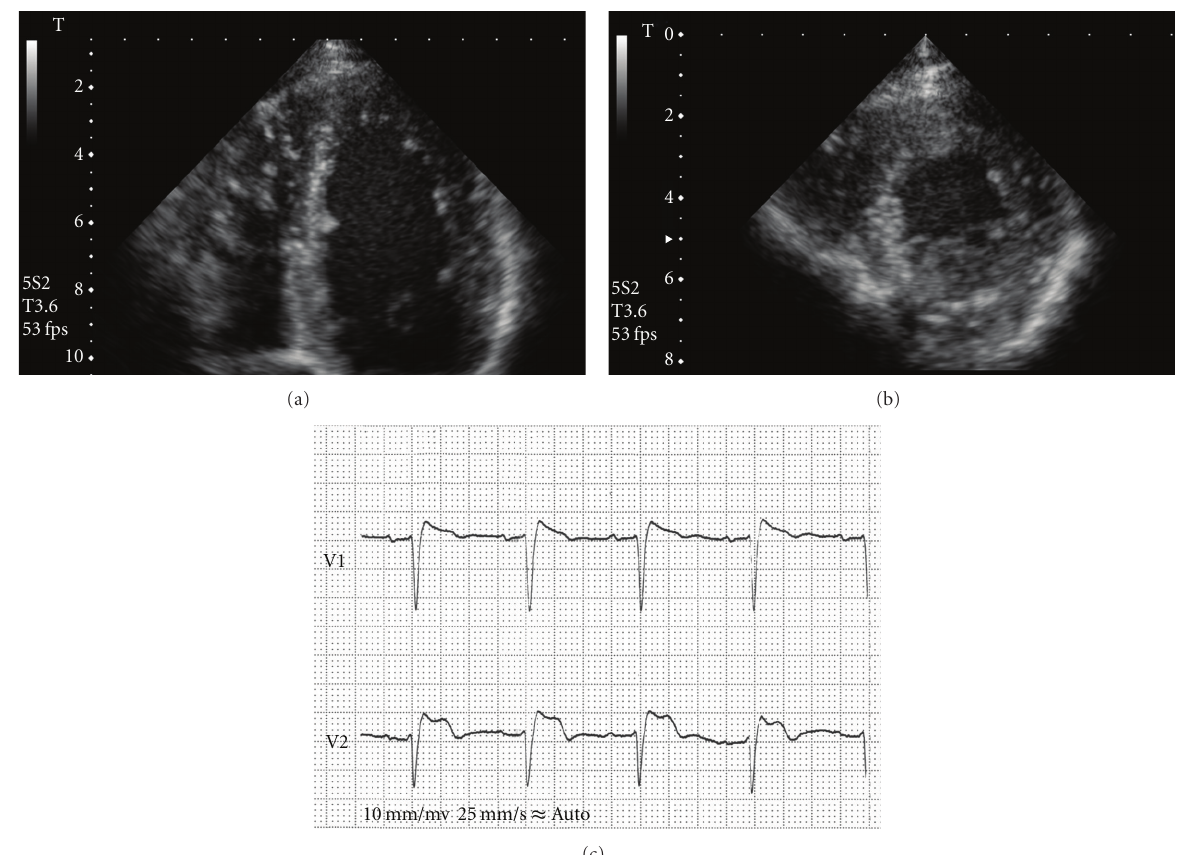
Figure 1: (a) Four-chamber view showing left and right ventricular noncompaction. The inner noncompacted layer is thick and hyperechogenic, and the outer is compacted and echolucent. This appearance is more markedly visible on the left ventricle’s lateral wall and apex and on the right ventricle’s free wall and apex. (b) Left ventricular short axis view showing noncompacted areas in the apex. (c) Type-2 ECG pattern with ST-segment elevation followed by a positive T wave in V1 and V2 consistent with Brugada